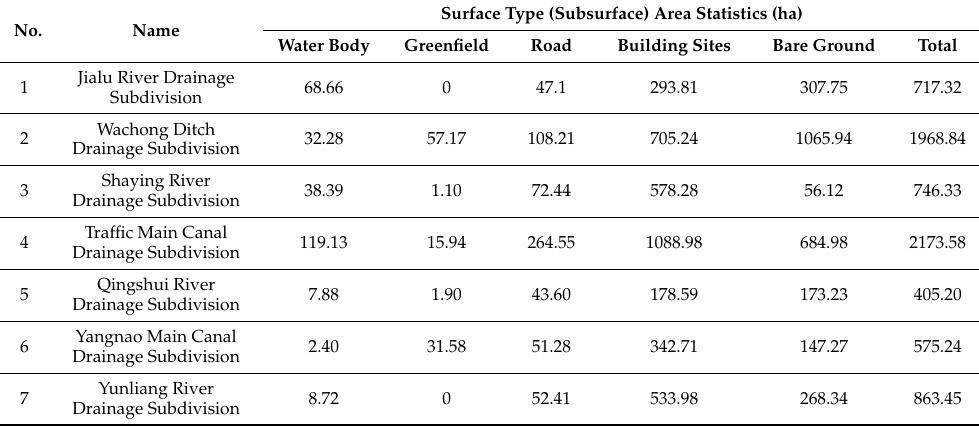
Table 1. Surface types (lower bedding surface) in the central city of Zhoukou.